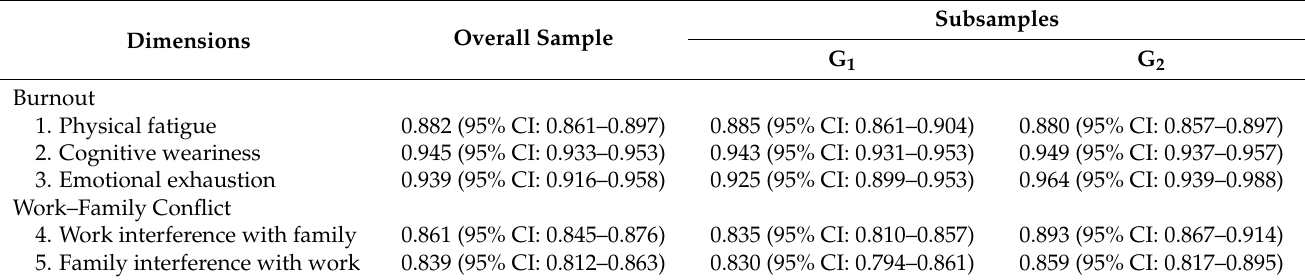
Table 3. McDonald’s omega ( ω ) coefficient estimates for burnout and work–family conflict dimensions. Dimensions